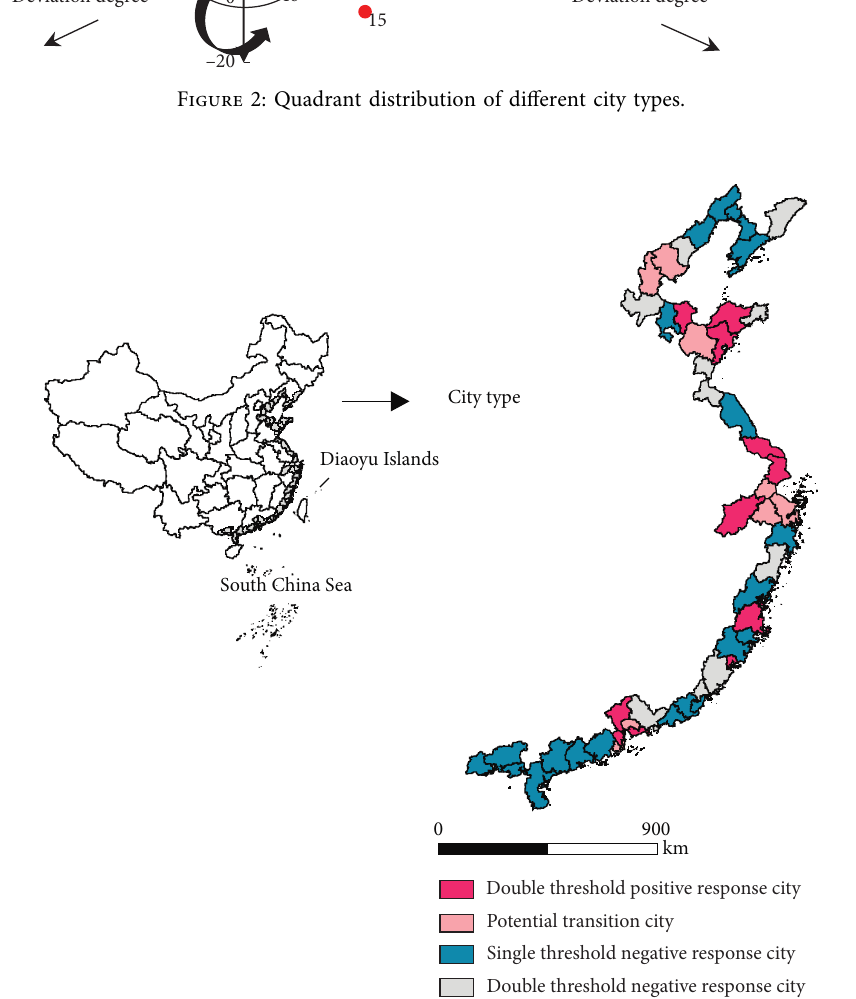
Figure 3: City type identification